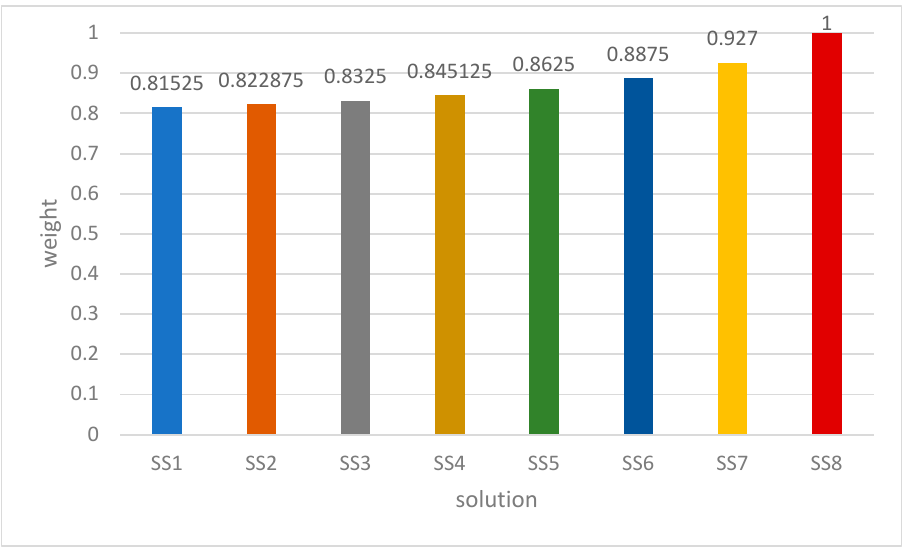
Figure 11. Prioritizing the suitable designs of the subtracting amplifier.